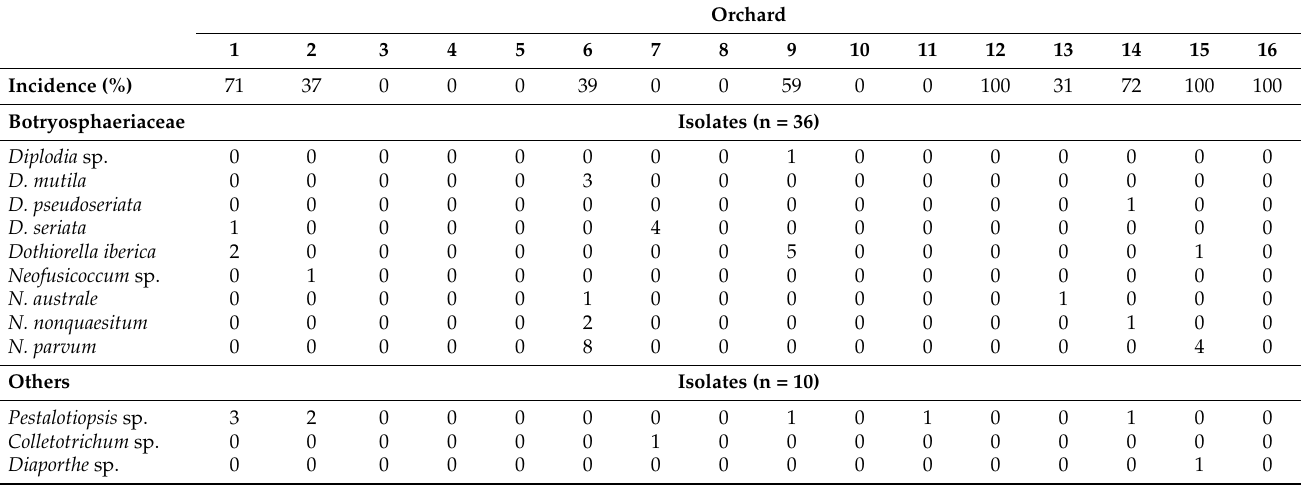
Table 2. Incidence of branch canker and dieback and the species of Botryosphaeriaceae associated with each Chilean orchard in this study.